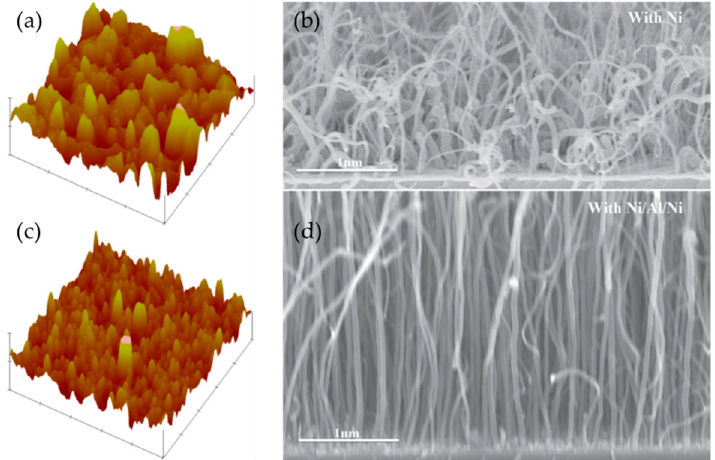
Figure 4. AFM representation of the top surface topography of ( a ) pure Ni and ( c ) multilayer catalyst/DBL/catalyst Ni/Al/Ni (scale bar 2 µm and 1µm, respectively). SEM micrographs of CNT grown on TiSi at 650 °C with ( b ) pure Ni catalyst and ( d ) multilayer Ni/Al/Ni interface. Reprinted with permission from Li, Diamond and Related Materials; Ref. [91] copyright 2017, Elsevier.